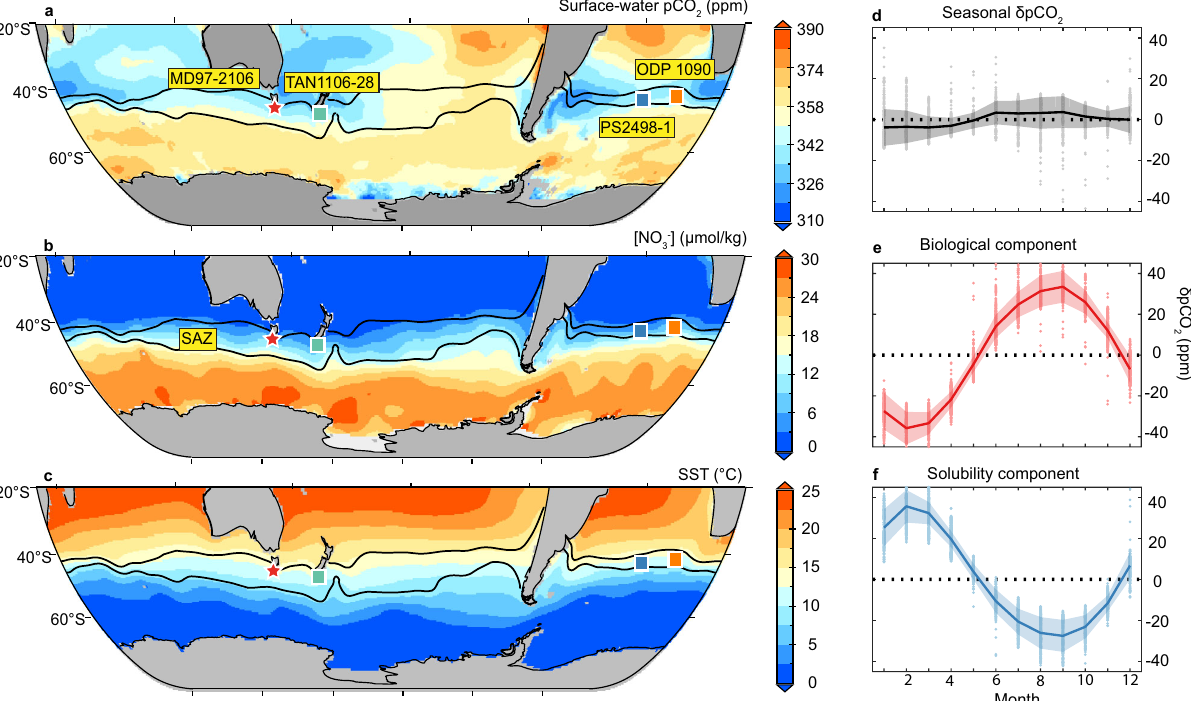
Fig. 1 | Surface-water chemistry in the modern Southern Ocean. a Annual mean surface-water pCO 2 during years 1985 – 2018. The map is made from data pre- sented in Gregor and Gruber 29 . https://creativecommons.org/licenses/by/4.0/. b Annual mean surface-water nitrate concentration. The map is made from data presented in Garcia et al. 48 , accessible from https://www.ncei.noaa.gov/access/ world-ocean-atlas-2018/. c Annual mean sea surface temperature. Two black curves indicatethe modern positionsof the SubtropicalFront(STF; the northern curve)andtheSubantarcticFront(SAF;thesoutherncurve),respectively,andthe region between them is the Subantarctic Zone (SAZ). The red star represents the location of our study site MD97-2106, and squares represent locations with published δ 11 B-based surface-water pCO 2 reconstructions in the SAZ. The map is